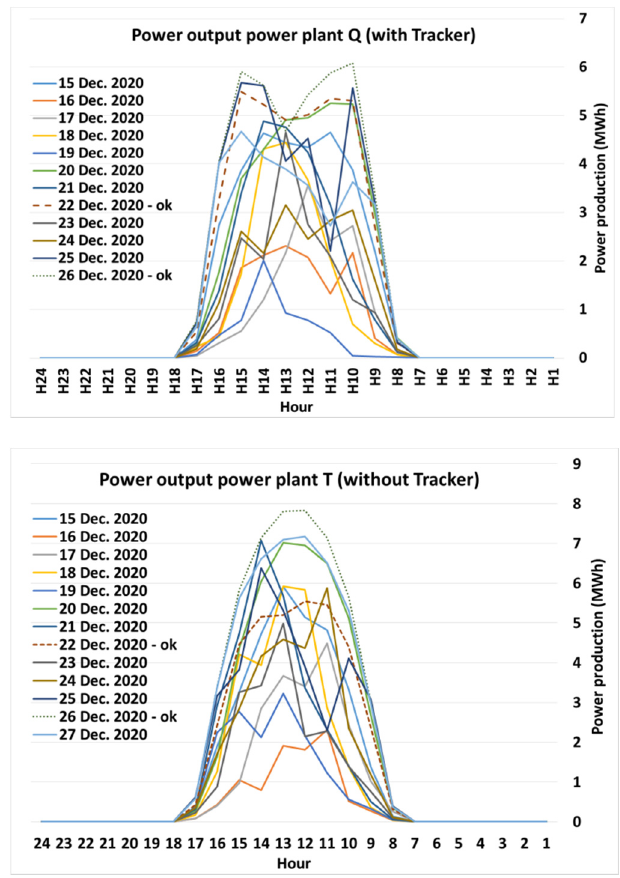
Figure 4. Production curve of two power plants, Q and T, with the aim of finding a suitable day for comparison in winter.